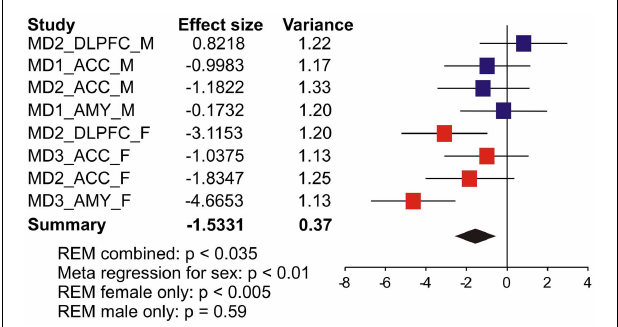
FIGURE 2 | Somatostatin (SST) expression is more robustly down-regulated in women with MDD . Results from eight microarray studies [MDD subjects ( N = 52) versus controls ( N = 51)] were combined by meta-analysis.Two studies were performed in dorsolateral prefrontal cortex (DLPFC), four in anterior cingulate cortex (ACC), and two in amygdala (AMY). Half of the studies were performed in female subjects in each region. X -axis indicates effect of MDD.The left-hand columns list the names of the studies and the effect size values.The summary effect of each study is depicted as a point estimate (mean effect size) bounded by its 95% confidence interval ( ± 1.96 standard deviation), represented by horizontal lines.The summarized effect is plotted as a diamond, which is shown on the bottom line with the associated REM p -value.The lack of overlap with the vertical no-effect line (effect size = 0) for the summarized diamond indicates statistical significance of the meta-analysis.